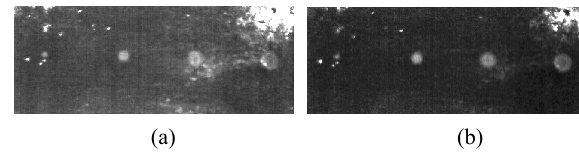
Fig. 8 Thermal image reconstructed by the piecewise fitting method: (a) raw image and (b) reconstructed